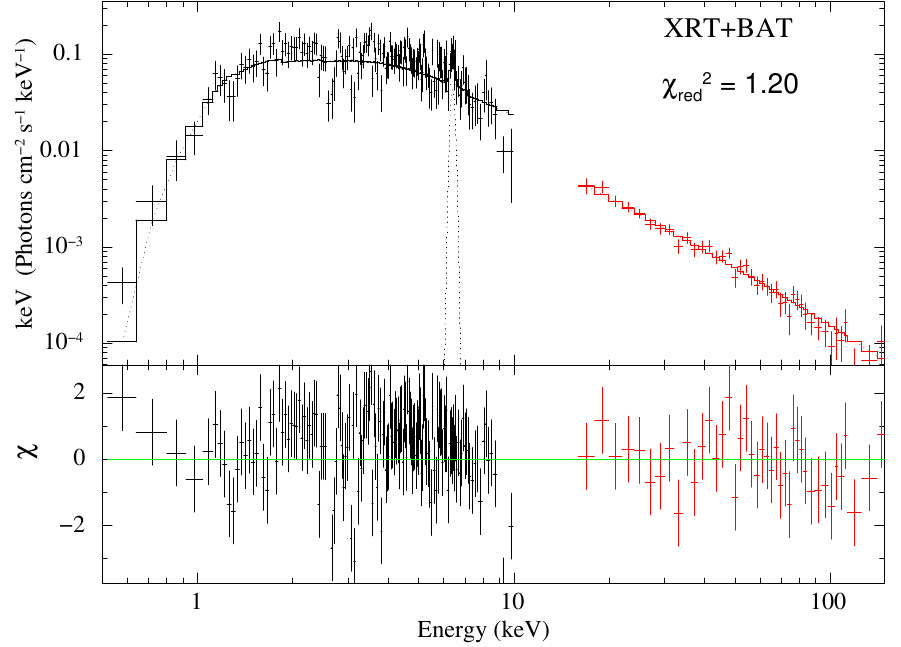
Figure 5. TCAF model fitted combined XRT+BAT spectra in the energy range of 0.5–150 keV, observed on MJD 57,191.03.